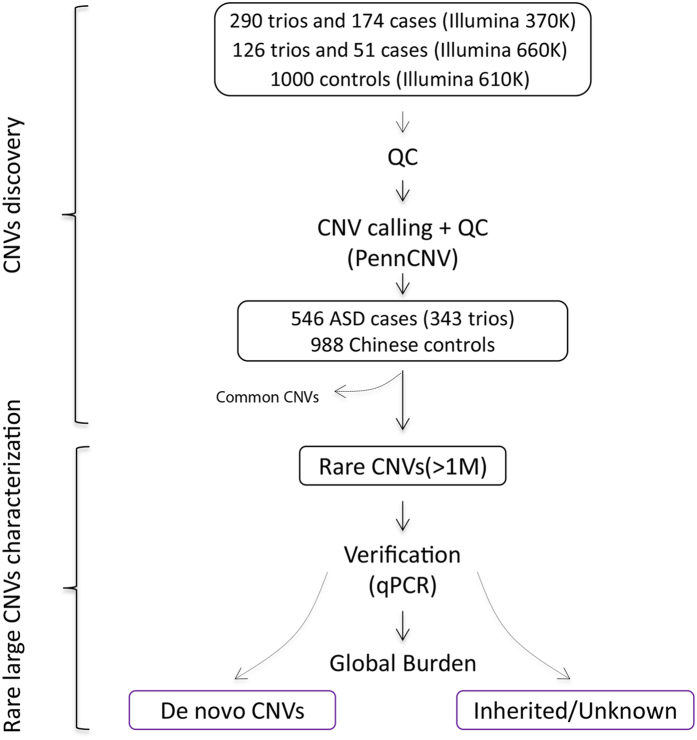
Pipeline of CNV discovery and analysis.ASD patients and parents were genotyped by an Illumina 370 K or 660 K BeadChip. Control subjects were genotyped using an Illumina 610 K BeadChip. CNV calling and quality control were performed using the PennCNV program. Rare, large CNVs (>1 Mb) were used for validation and analysis. The global burden was subsequently determined. De novo CNVs and inherited CNVs were characterized.